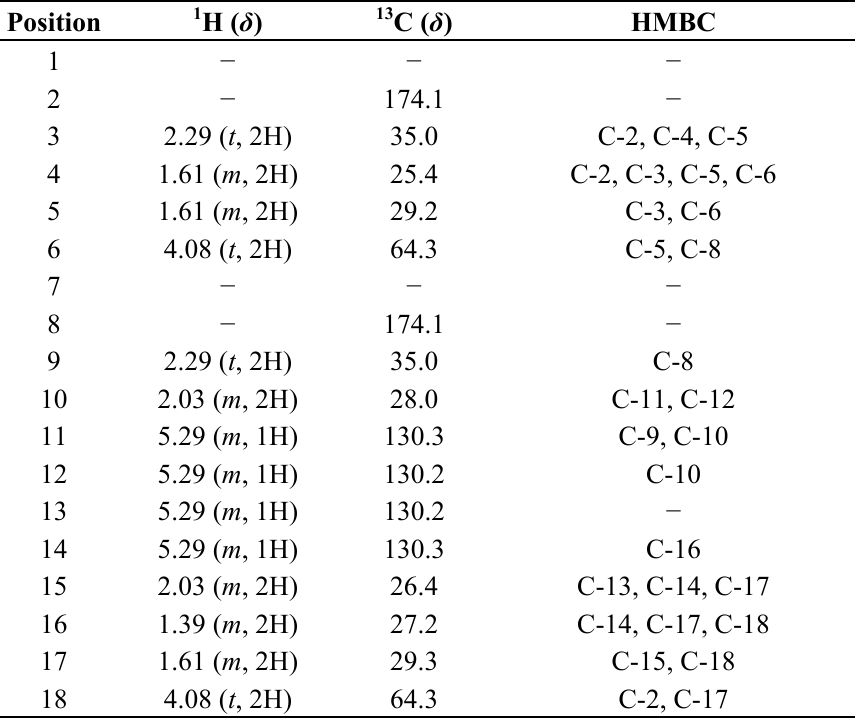
) data for compound 1 . 3